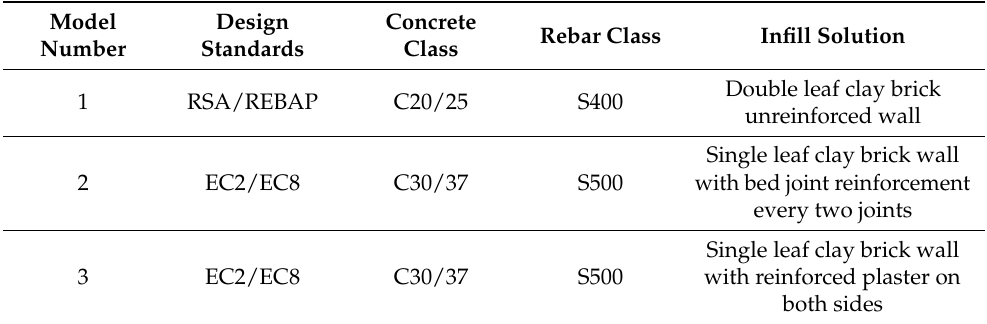
Table 3. Description of the tested